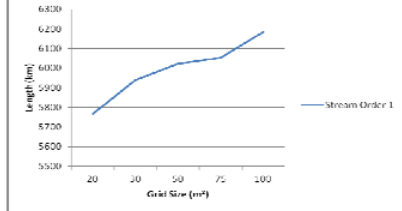
Figure 11. Stream Order 1 Waterways derived from 20m DEM resized to 30m, 50m and 75m and 100m DEMs